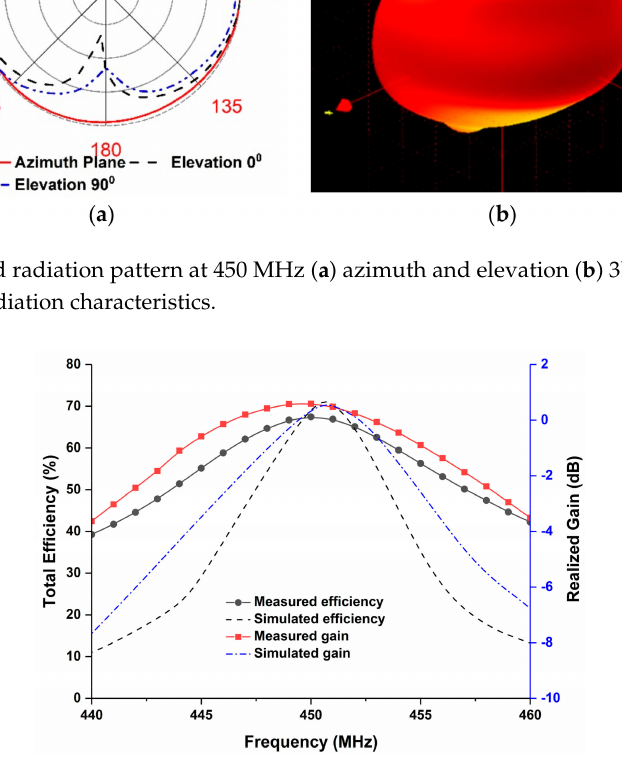
Figure 9. Simulated and measured total efficiency and gain of the fabricated prototype; where 67.45% efficiency is achieved with 0.6 dB of realized gain.